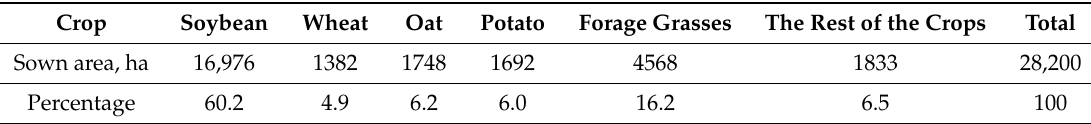
Table 1. The sown areas’ structure by crops (Khabarovsk district, 2018).